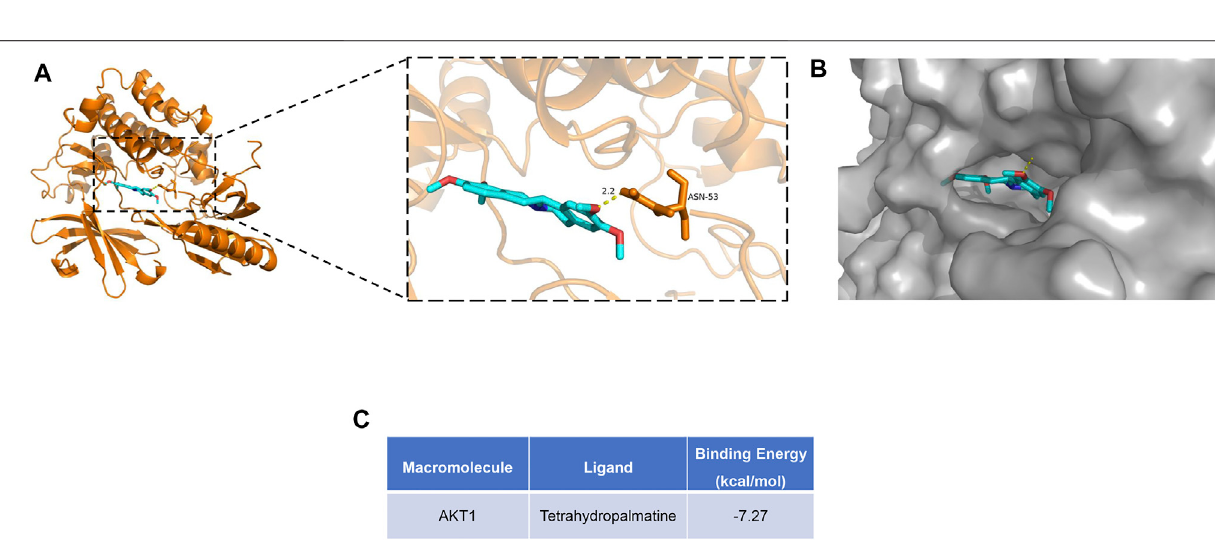
Frontiers in Pharmacology |